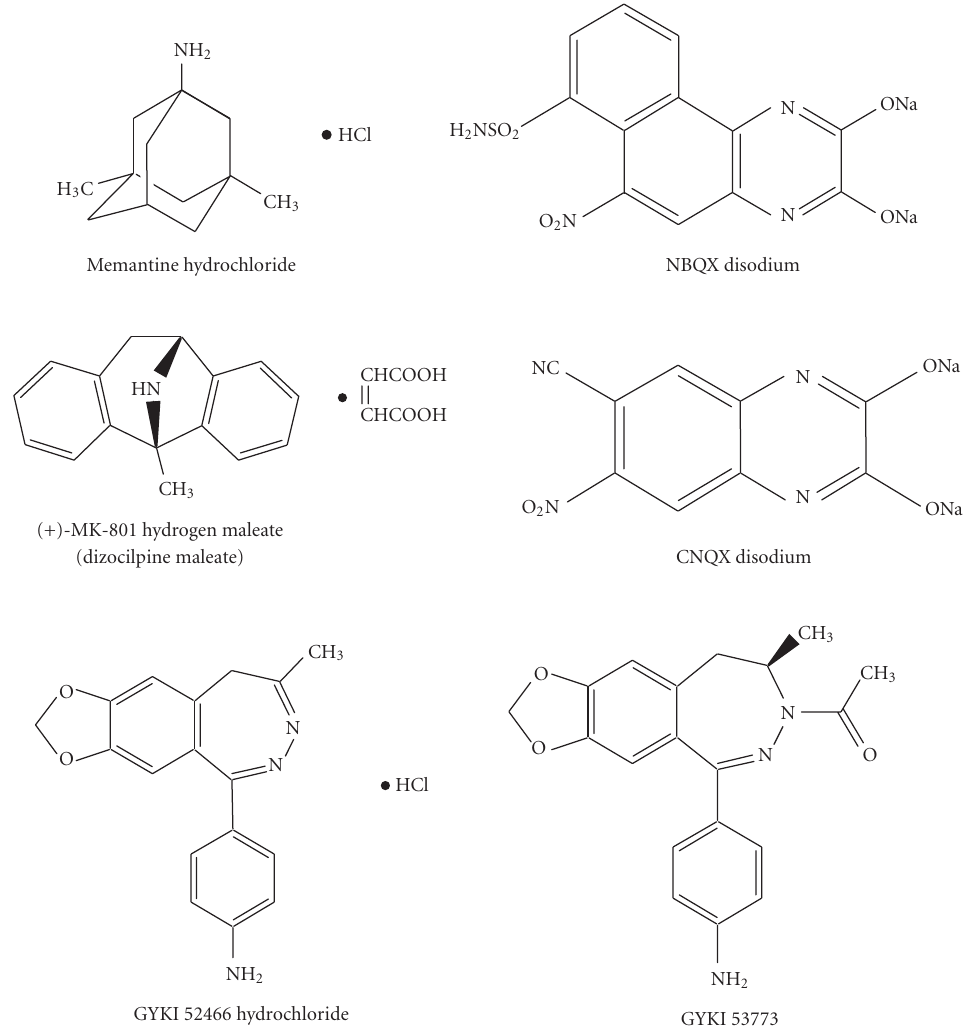
Figure 3: Chemical structures of the main pharmacological agents employed in EAE